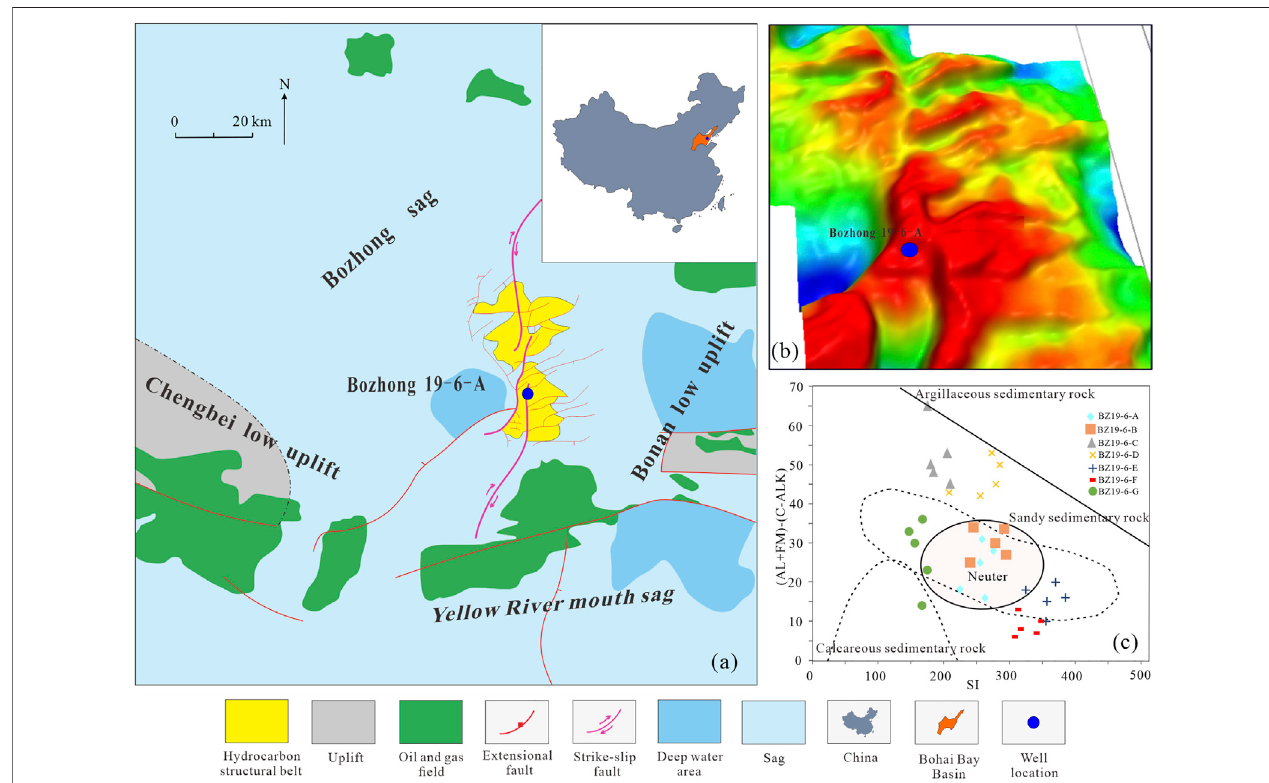
FIGURE 1 | Geological background of the Bozhong 19-6 area. (A) Bozhong 19-6 structure and the location of sampling wells (Hou et al., 2019); (B) Three- dimensional view of the Archean buried hill structure; (C) Archean buried hill original rock restoration (Simonen et al., 1953).